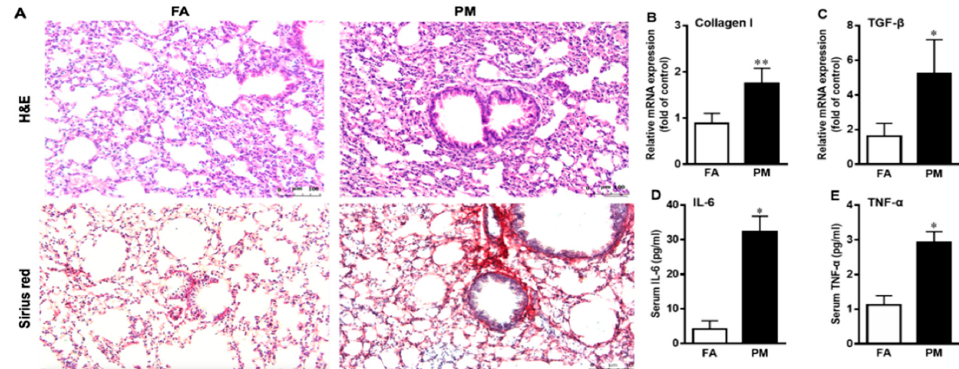
Figure 2. PM 2.5 exposure induces pulmonary inflammation and fibrosis. ( A ) Lung sections from filtered air (FA) and particulate matter (PM 2.5 )-exposed mice were stained with hematoxylin and eosin (H&E) and Sirius red staining at 200× magnification. ( B – E ) After exposure for 12 weeks, the mRNA levels of fibrotic genes collagen I and transforming growth factor β (TGF- β ) in lungs ( B , C ) and the level of inflammatory factors interleukin 6 (IL-6) and tumor necrosis factor α (TNF- α ) in serum ( D , E ) were measured by qPCR and enzyme linked immunosorbent assay (ELISA) kits, respectively. Data are presented as mean ± standard deviation (SD); * p < 0.05, ** p < 0.01 vs. FA group.